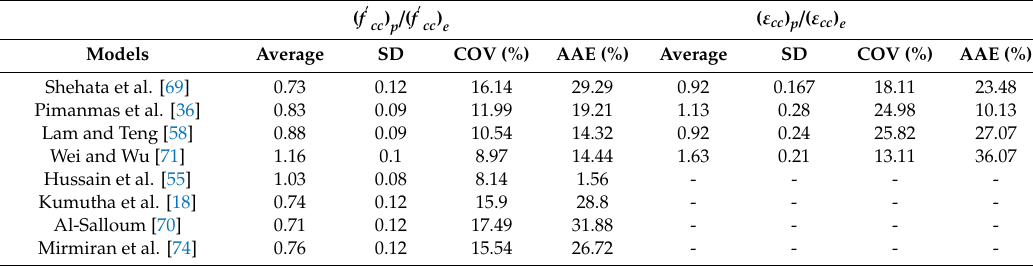
Table 13. Statistical performance of the strength model vs. experimental data of square